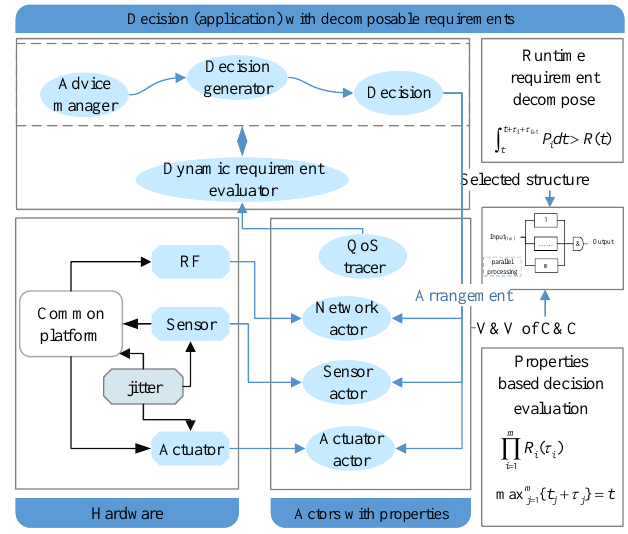
Figure 7. Actor-based decision evaluation and self-management based on requirements management (RF: Radio Frequency devices).